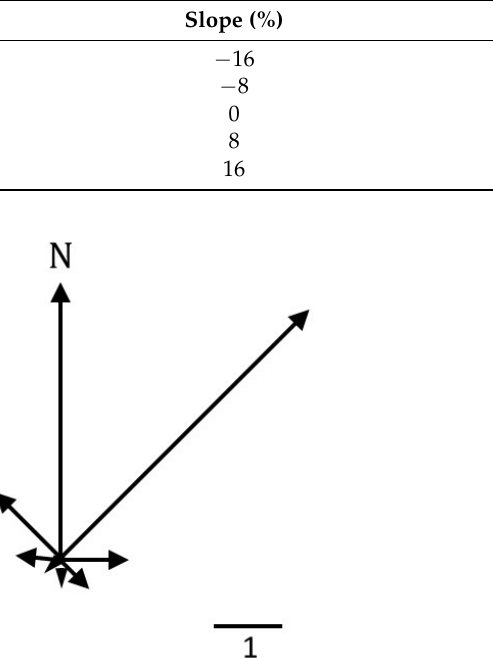
Table 3. Fire spread slope multipliers using McArthur’s fire danger meter [20].